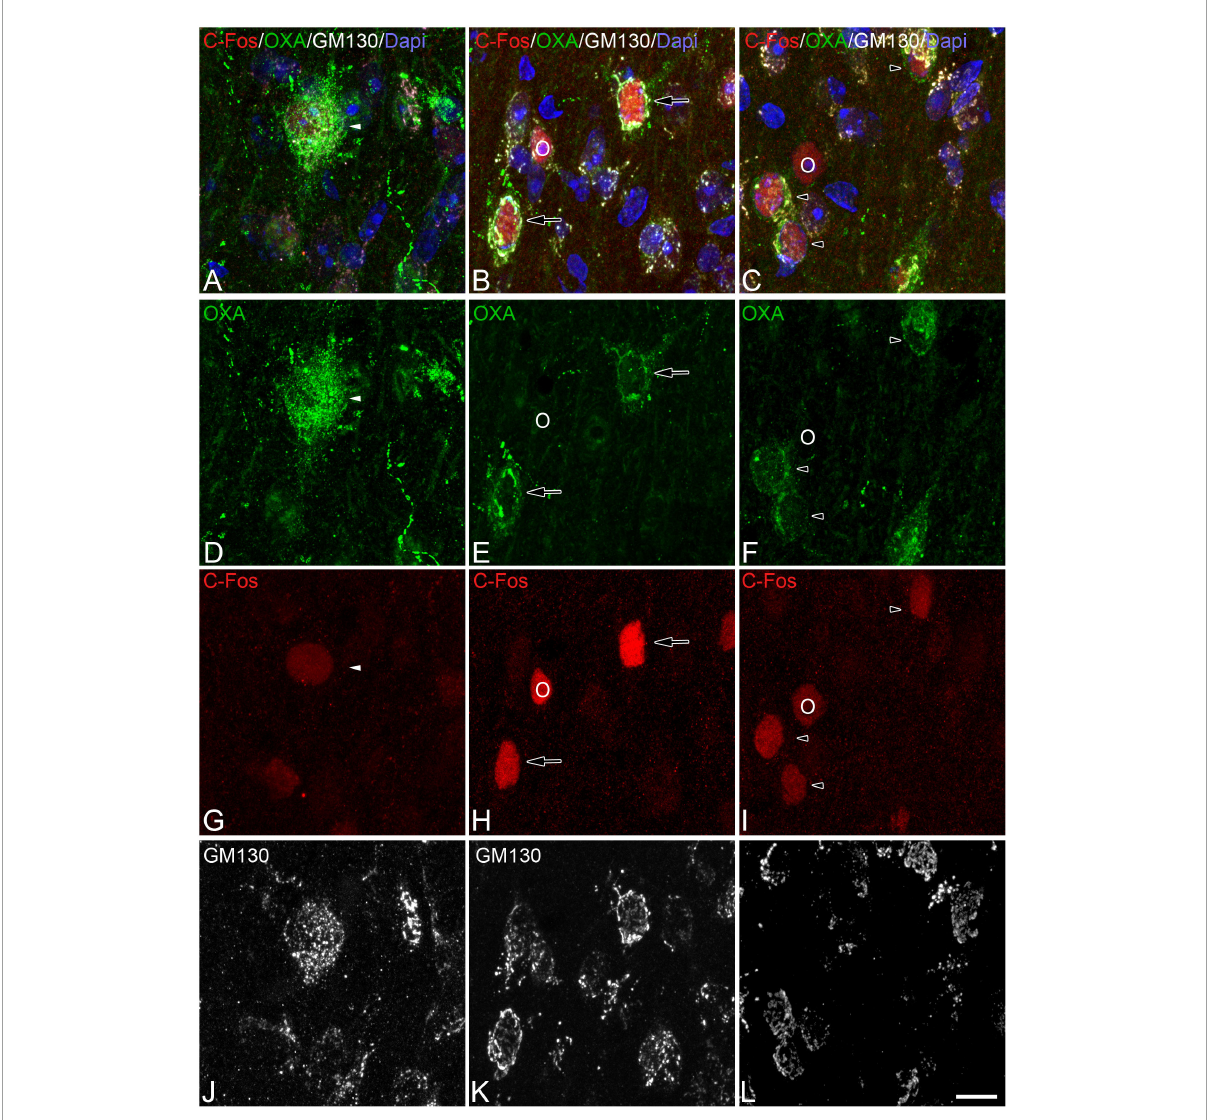
FIGURE5 (A-D-G-J, B-E-H-K, C-F-I-L) Groups of confocal projection images taken from OXA/C-Fos/GM130 triple-immunostained sections and counterstained with DAPI, showing examples of LH orexinergic neurons, from Syrian hamsters at torpor, with different patterns of immunostaining. Solid arrowheads in panels (A,D,G) point to an orexinergic neuron with intense OXA immunostaining showing moderate C-Fos expression. Note the presence of orexinergic neurons with moderate OXA immunostaining showing intense [hollow arrows in panels (B,E,H) ] or moderate [hollow arrowheads in panels (C,F,I) ] C-Fos expression. The O symbols indicate examples of non-orexinergic neurons with intense (B,E,H) or moderate (C,F,I) C-Fos expression. Also note both orexinergic and non-orexinergic LH neurons in torpid hamsters showing altered (fragmented) patterns (see text) of the GA, as revealed by GM130 immunostaining. Scale bar shown in panel (L) indicates 10.5 µ m.